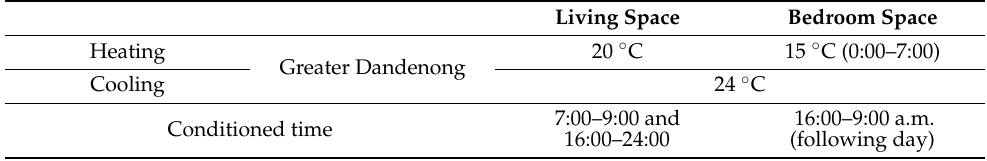
Table 5. Required condition time and thermostat setting.